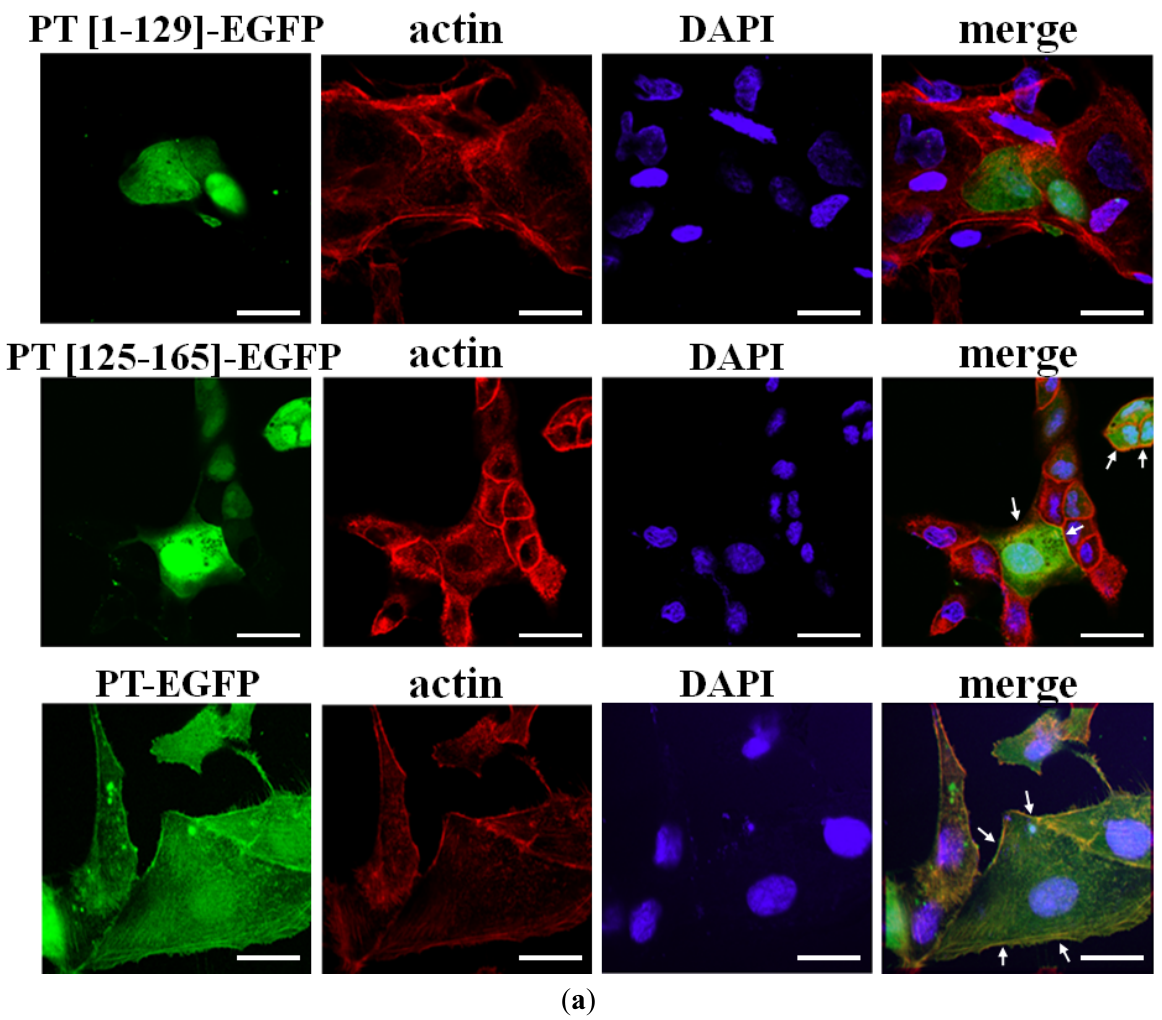
Figure 2. Phostensin (125–165) binds to F-actin. ( a ) Colocalization of phostensin (125–165) and F-actin in MDCK cells. F-actin was stained with rhodamine-phalloidin. Nuclei were stained with DAPI. Fluorescence for PT-EGFP (green) (or PT(1–129)-EGFP (green) or PT(125–165)-EGFP (green)), F-actin (red), and nuclei (blue) are shown on the merged images. Phostensin or PT(125–165) is conspicuously colocalized with F-actin in the cell periphery, as indicated by the arrow. The bar represents 20 μ m; ( b ) SDS-PAGE (12.5%) analyses of trx-PT, trx-PT(1–129) and trx-PT(125–165). Molecular weight markers from top to bottom are phosphorylase b (97 kDa), bovine serum albumin (66 kDa), ovalbumin (45 kDa), carbonic anhydrase (30 kDa) and trypsin inhibitor (21.5 kDa); ( c ) Trx-PT(125–165) co-sediments with F-actin at high speed centrifugal forces (150,000 g ). Protein distributed in the pellet (p) and supernatant (s) were analyzed by SDS-PAGE (12.5%). Trx-PT and trx-PT(125–165) were analyzed by western blotting with anti-(His) antibodies. To analyze 6 the distribution of actin in the supernatant and pellet, the anti-(His) antibodies on the 6 blotted membrane were deleted by the striping buffer (0.5 M acetic acid plus 0.5 M NaCl), and the membrane was re-blotted with anti-actin polyclonal